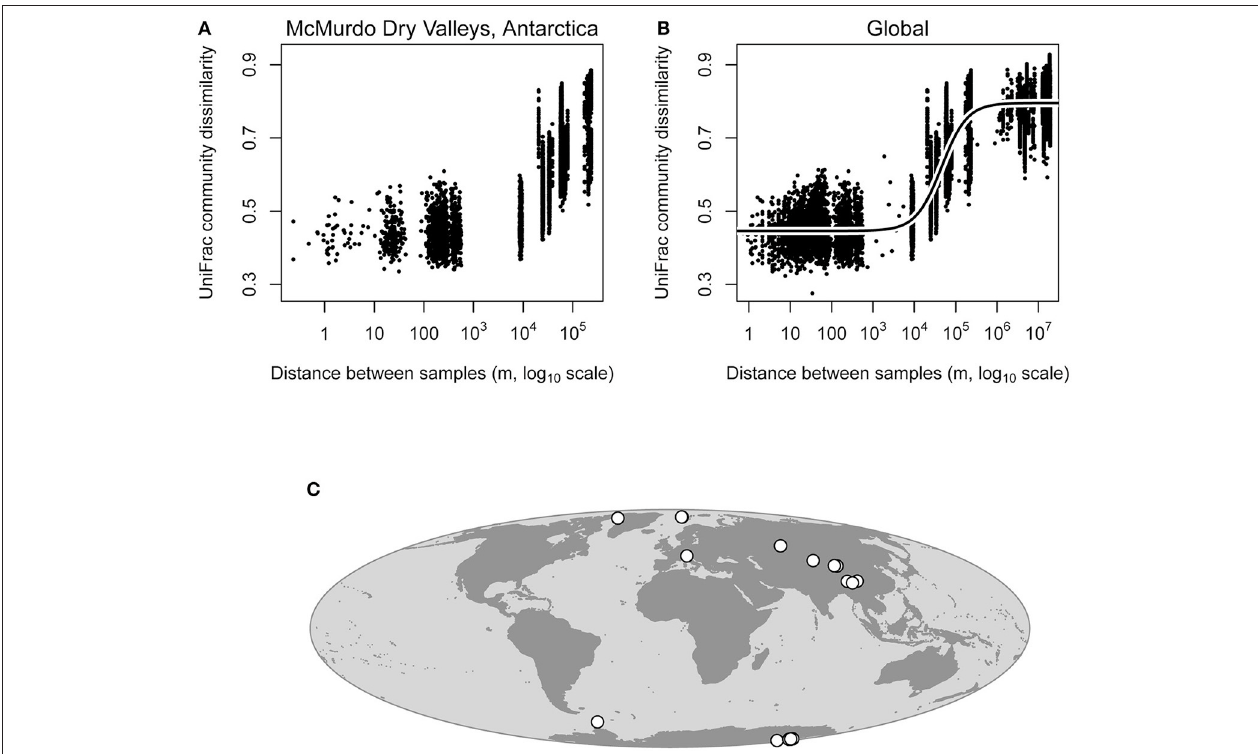
FIGURE 3 | Distance decay of similarity analysis for cryoconite hole bacterial communities within the McMurdo Dry Valleys and globally. Note that UniFrac distance (Y-axes) is a distance metric rather than similarity, thus it increases as a function of geographic distance. Distance decay of similarity within the Dry Valleys was highly statistically significant (Mantel test; P = 0.001, r M = 0.718), meaning that geographically close cryoconite holes are likely to harbor similar bacterial communities, and geographically distant cryoconite holes are more likely to harbor more different bacterial communities (A) . Distance decay of similarity in the global data set was also statistically significant (Mantel test; P = 0.001, r M = 0.888), meaning that the pattern observed in Antarctic Dry Valleys glaciers still holds when glaciers from around the Earth are included in the analysis (B) . These data fit a logistic model much better than it fit a linear model ( Supplementary Figure 3 , R 2 = 0.879), owing to